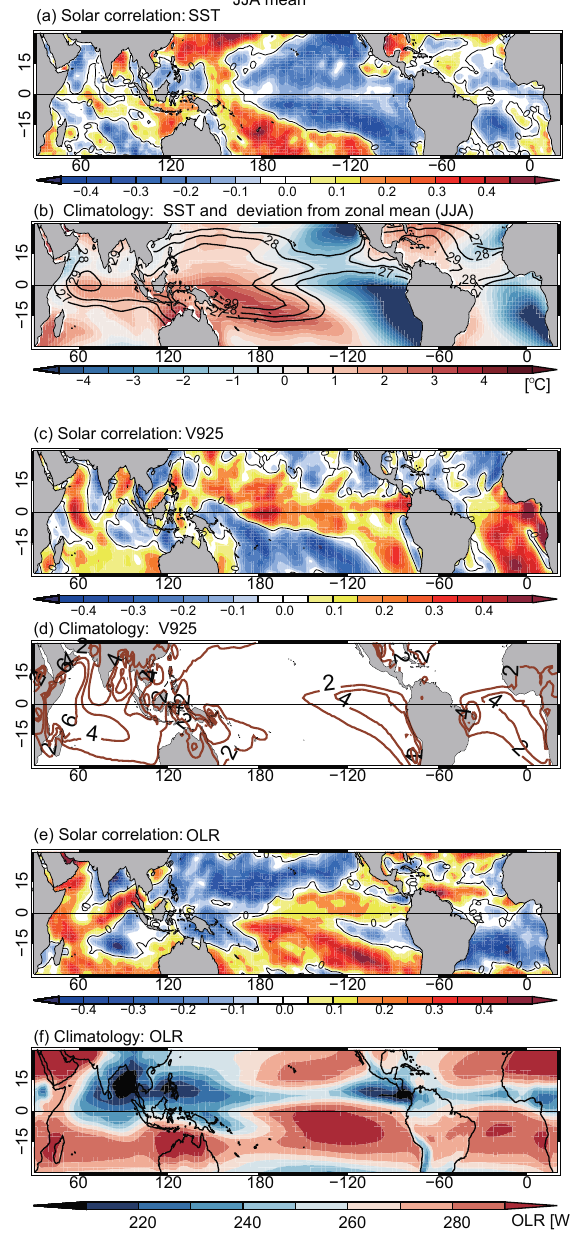
Figure 11. Boreal summer (JJA) solar signal in (a) SST, (c) merid- ional winds at 925hPa and (e) OLR, presented as correlations with the solar index for the period 1979–2010. (b) JJA mean climatolog- ical SST, with contours for 27, 28 and 29 ◦ C, and colour shading denoting the deviation from the latitudinal mean SST. (d) Climato- logical JJA northward wind component at 925hPa (contours every 2ms − 1 ) . (f) Climatological JJA OLR (colour